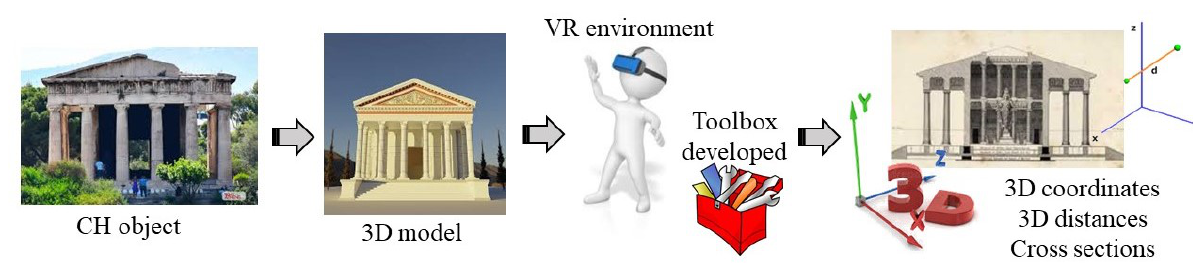
Figure 1 . Schematic concept of the VR toolbox